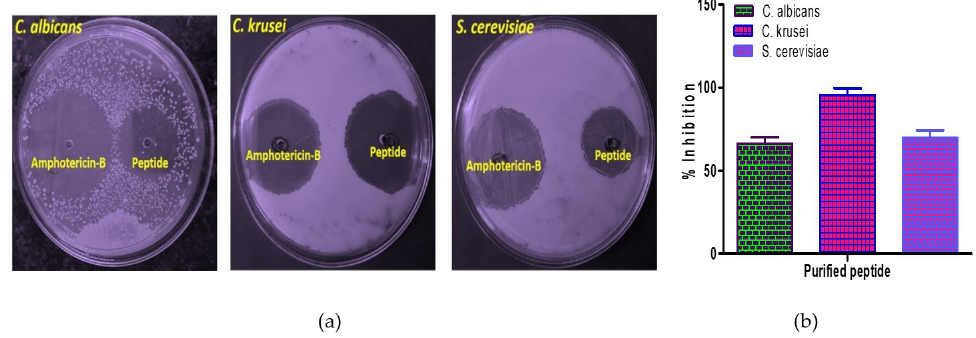
Figure 11. Antifungal activity of chickpea peptide towards ( a ) various human pathogen ( b ) zone of inhibition.